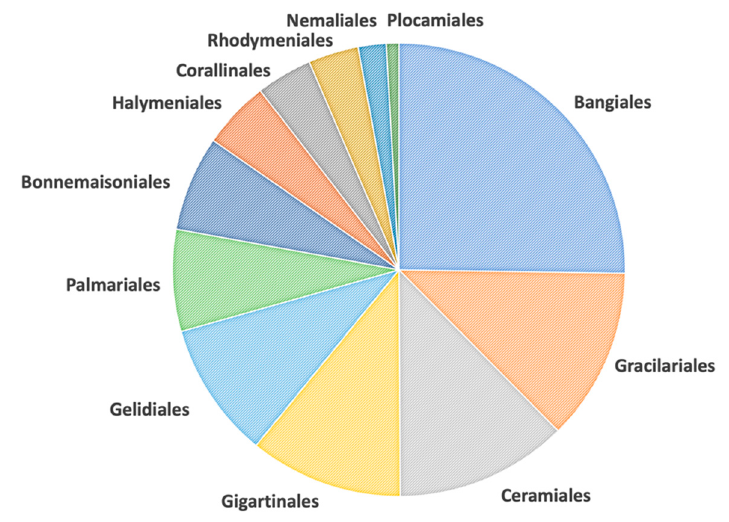
Figure 3. Distribution of MAAs in different orders of red macroalgae, according to the values obtained in previous studies [2,42,43,45,47].